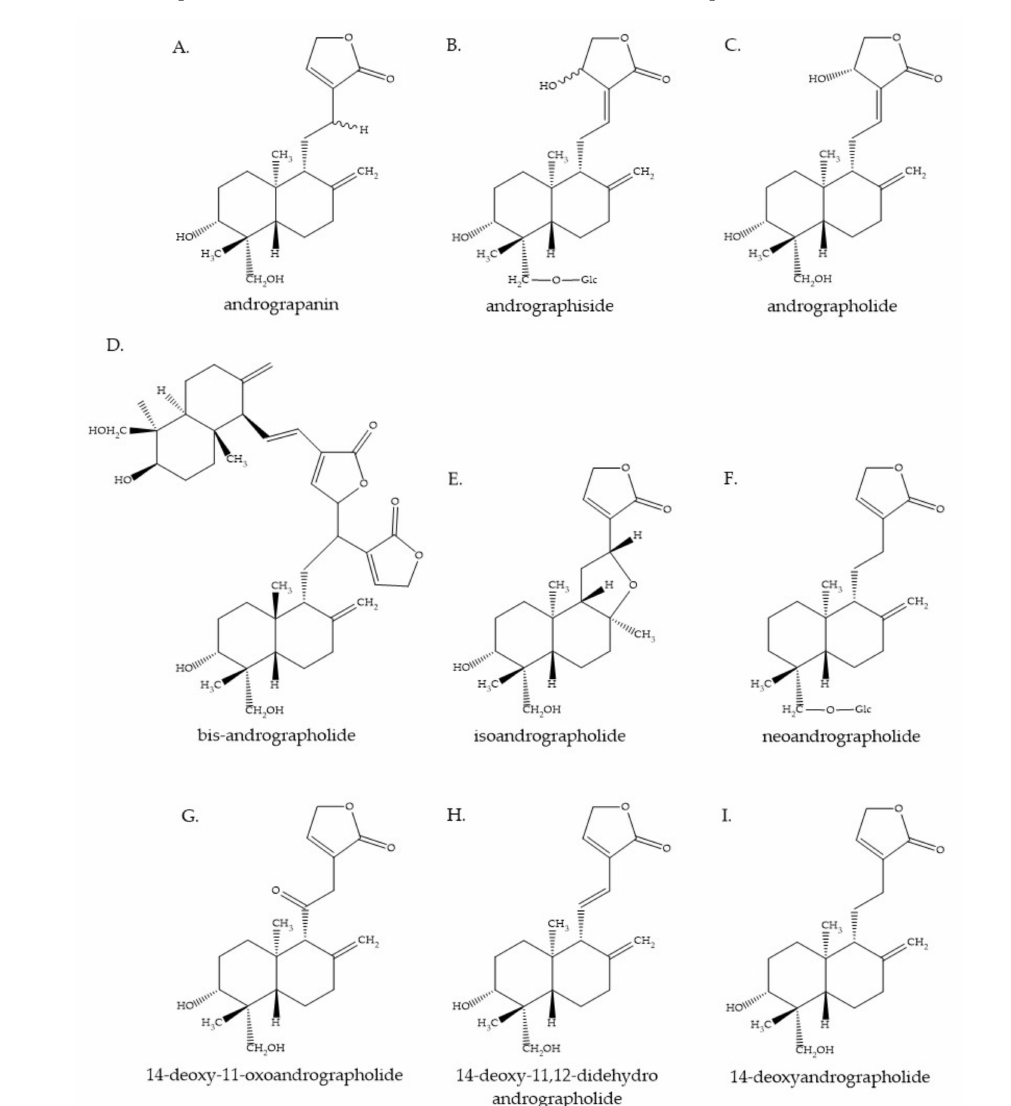
Figure 2. Some of the chemical constituents of Andrographis paniculata. ( A ): Andrograpanin, ( B ): andro- graphiside, ( C ): andrographolide, ( D ): bis-andrographolide, ( E ): isoandrographolide, ( F ): neoandro- grapholide, ( G ): 14-deoxy-11-oxoandrographolide, ( H ): 14-deoxy-11,12-didehydroandrographolide, and ( I ):